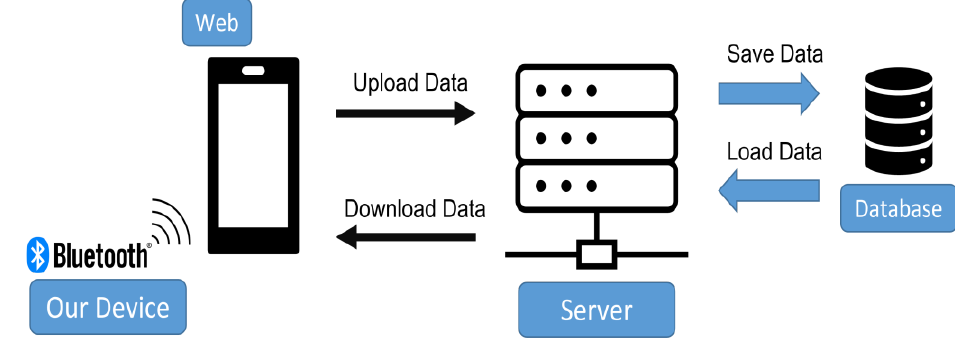
Figure 5. Block diagram of the software.